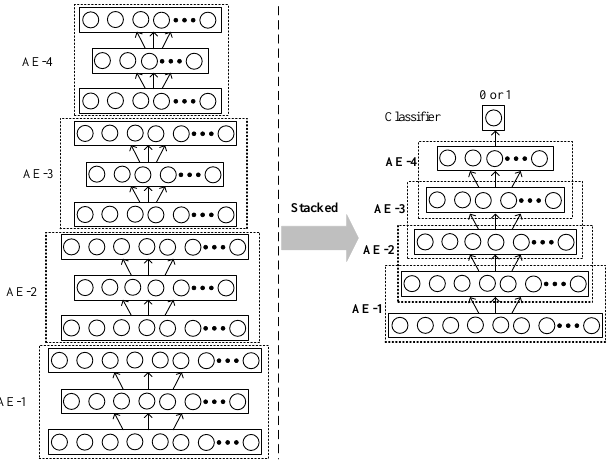
Figure 5. Brief architecture of SAE network.